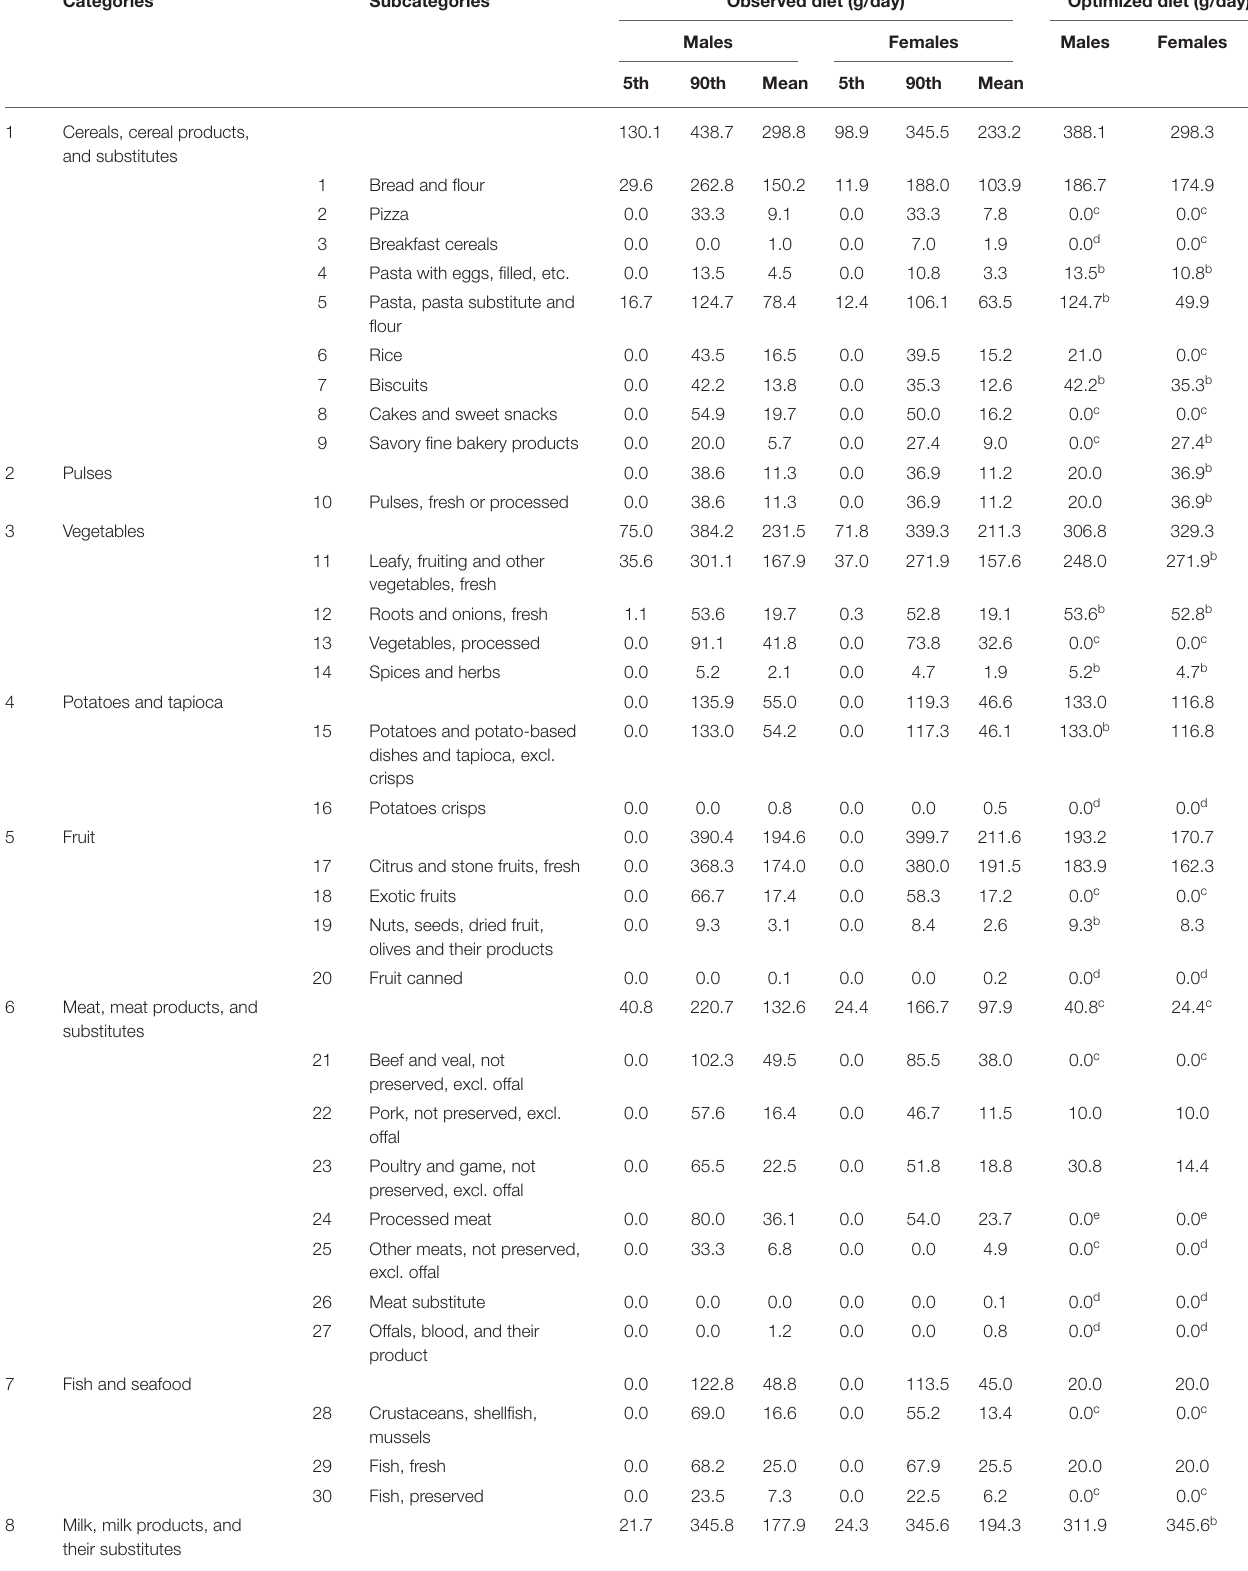
TABLE 3 | Food categories and subcategories of daily portion of the observed and optimized diets by the adult 18–60-year-old male and female population a .